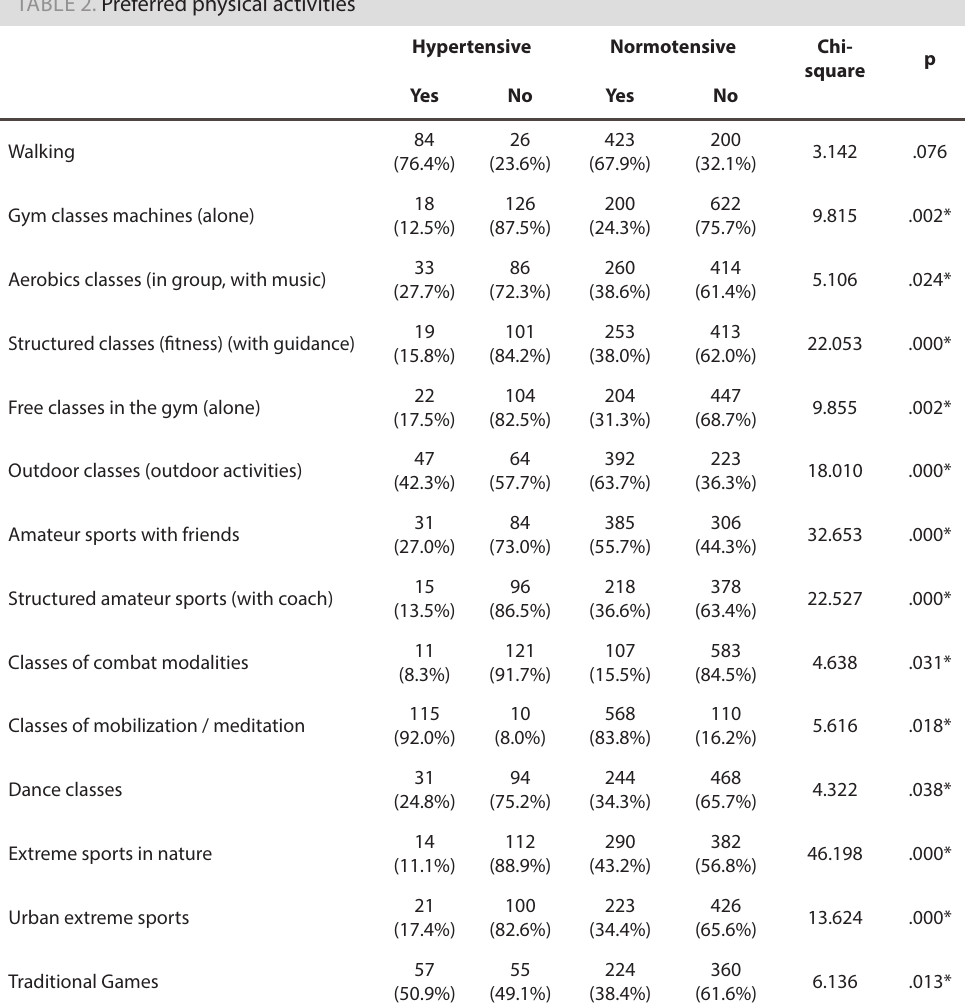
TABLE 2. Preferred physical activities